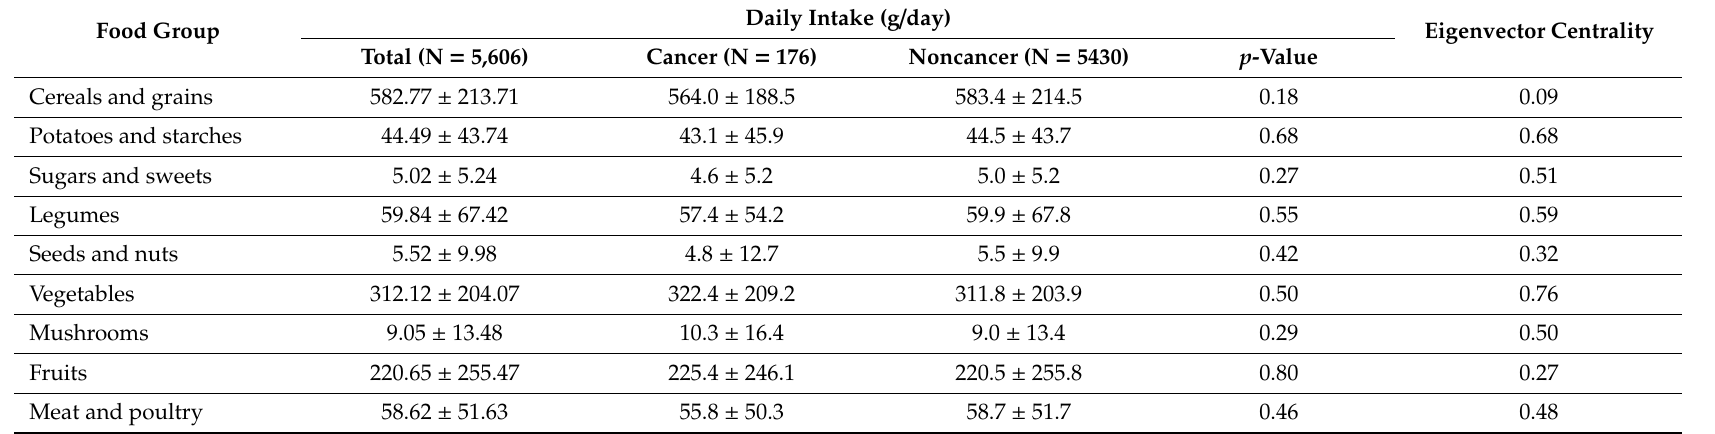
Table 2. Dietary intake of study population and eigenvector centrality of 16 food